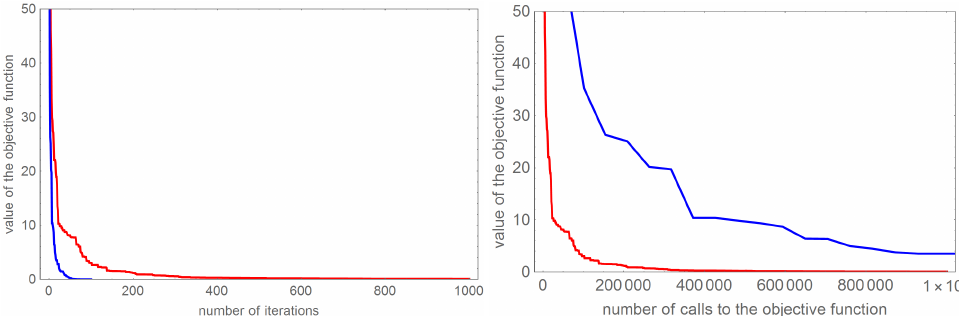
Figure 7. The left figure shows a comparison of the dependence of the objective function value on the number of iterations, while the right one shows the dependence of the objective function value on number of calls to the objective function. The results obtained with the DBOA algorithm are marked in red, and the results in blue are marked for the FA algorithm.